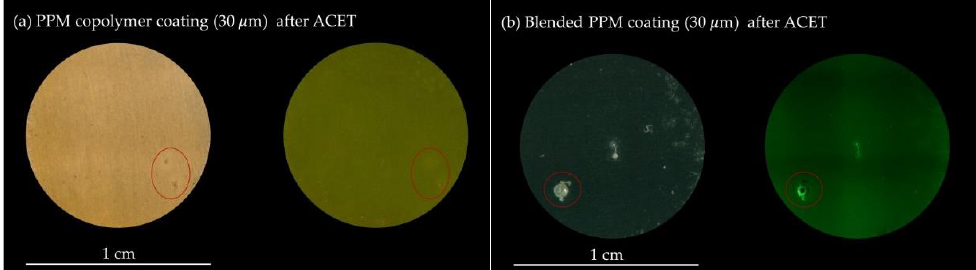
Figure 9. Optical microscopy images of the surface of ( a ) 30 μm PPM copolymer and ( b ) 30 μm blended PPM coating after exposition to the ACET under visible light ( left ) and under UV light at 254 nm ( right ). Macroscopic localized corrosion of the AA2024 substrate is marked with red circles.